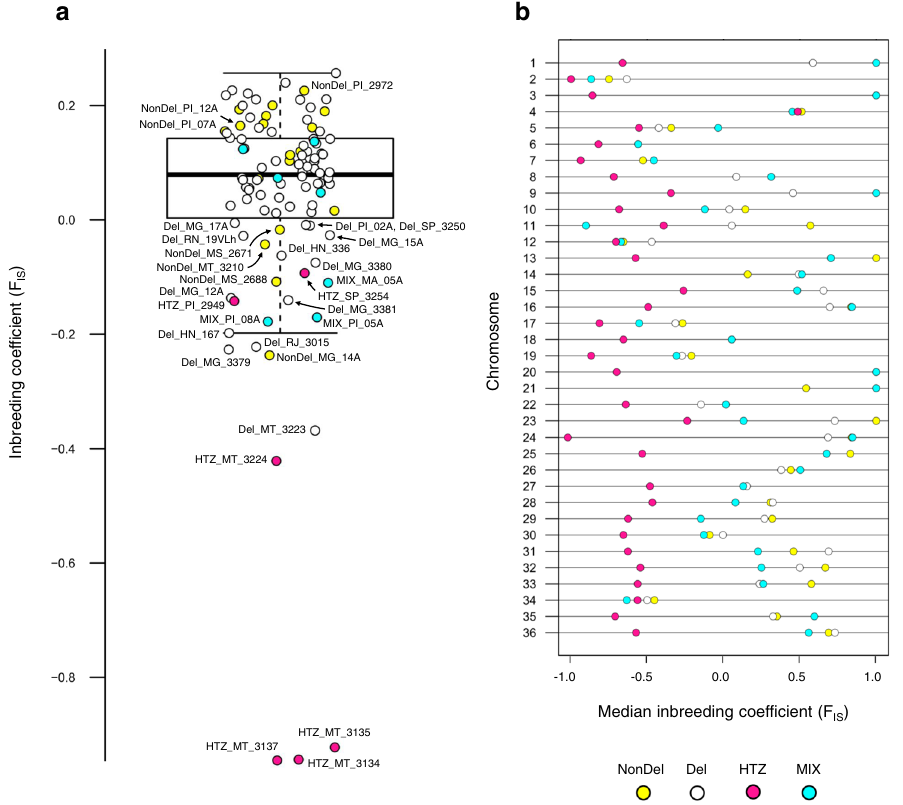
Fig. 3 Homozygosity relative to Hardy – Weinberg expectations in New and Old World L. infantum isolates. a The box plot shows median and interquartile ranges of genome-wide inbreeding coef fi cients (F IS ). Values are generally high for New World isolates. Values for HTZ isolates, however, all occur below the second quartile and strong excess heterozygosity is suggested in HTZ_MT_3134, HTZ_MT_3135, and HTZ_MT_3137. b Relatively low genome-wide F IS in HTZ isolates is not driven by values from a subset of chromosomes. Values appear low throughout the genome. Circle fi ll color indicates New vs. Old World origin and read-depth pro fi le on